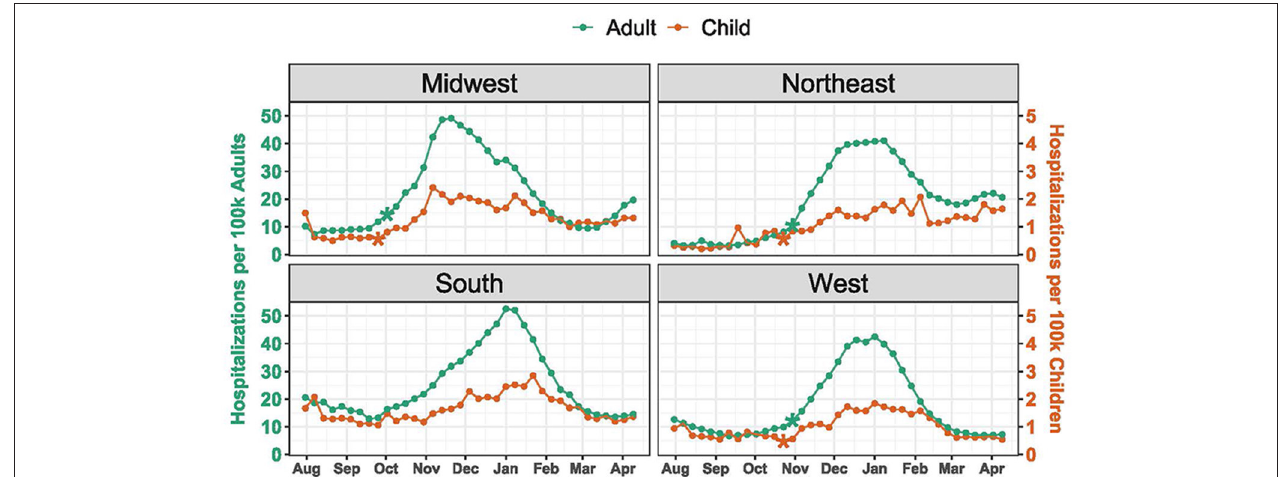
FIGURE 2 | COVID-19 Hospitalization Trends by Region. Hospitalizations were standardized per 100,000 children or adults using US Census population estimates. The scale for pediatric hospitalizations is 10-fold less than for adults. Asterisks indicate significant ( P < 0.005) change